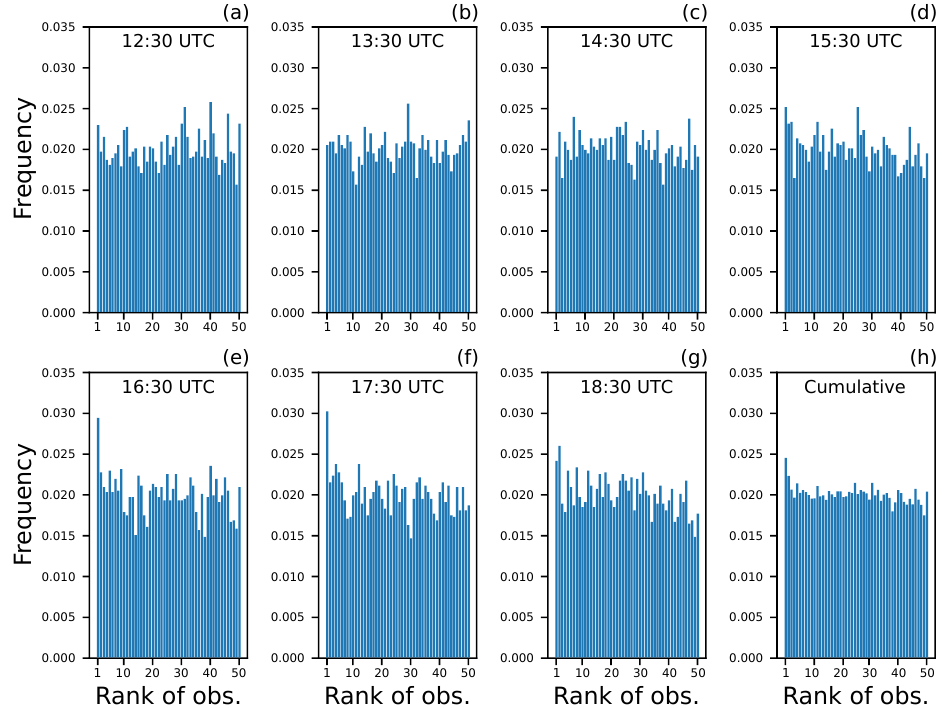
Figure 9. Panels from ( a – g ) show the rank histograms computed for the different time slices and considering all the points of the computational domain. The 49 ensemble members produce 50 bins (possible observation ranks). The cumulative histogram (panel ( h )) was constructed by summing histograms of panels from ( a – g